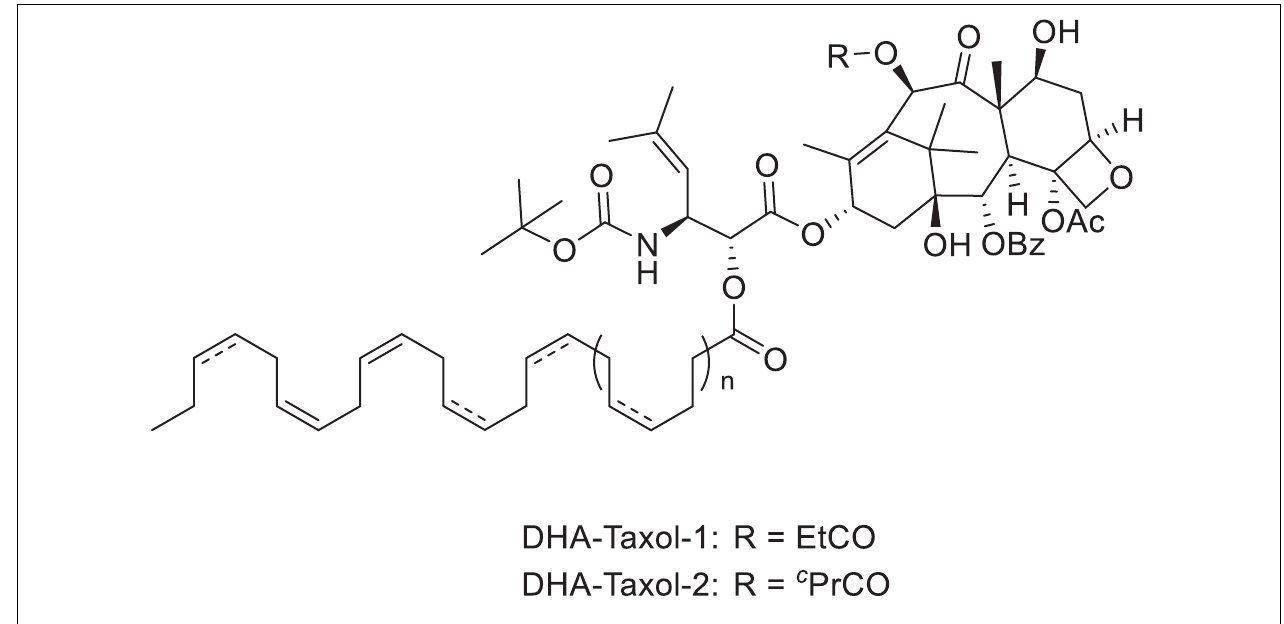
FIGURE 4 | The structures of two DHA–PTX